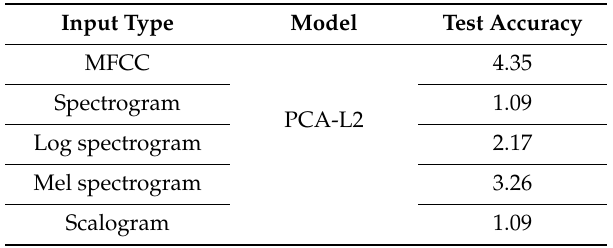
Table 7. Accuracies achieved by PCA-L2 using time-frequency representations on MIT (Massachusetts Institute of Technology)-BIH (Beth Israel Hospital)-arrhythmia-ECG.